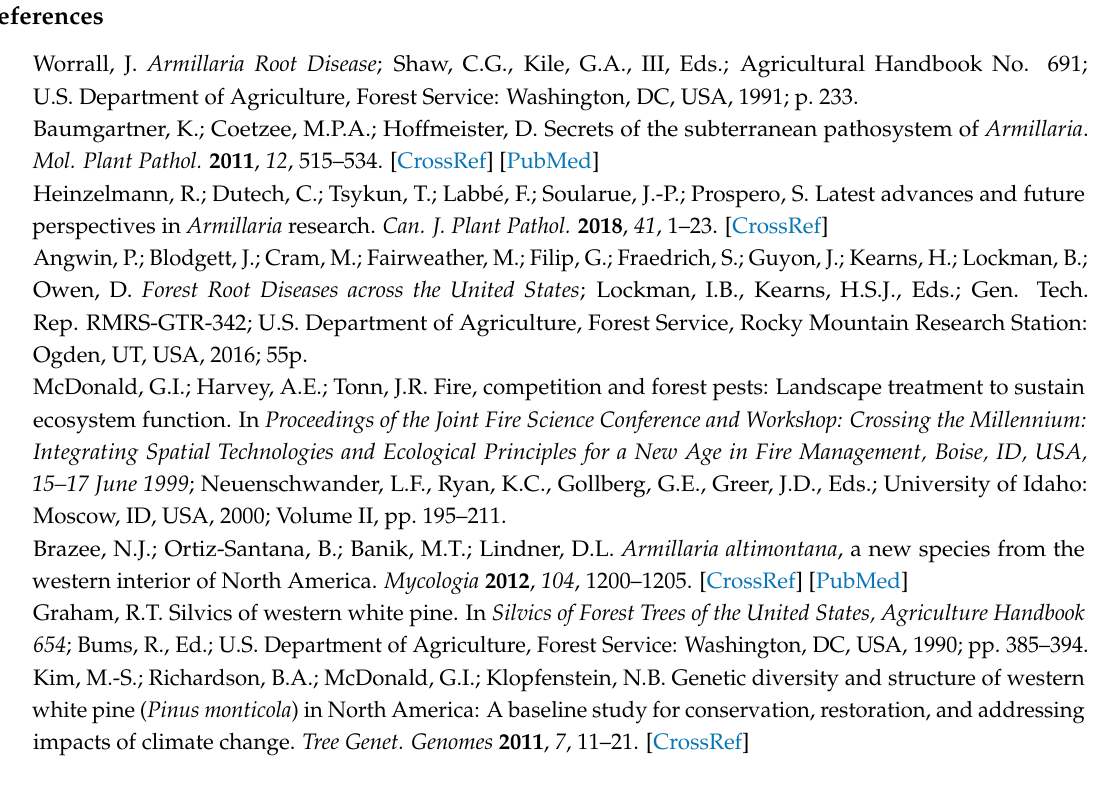
Table S1. The somatic pairing tests to identify the Armillaria genets among the isolates collected from western white pine ( Pinus monticola ) within a plantation at the Ida Creek site, Priest River Experimental Forest, northern Idaho, USA. Table S2. The number of western white pine ( Pinus monticola ) trees by region of seed origin and group status used for the analyses or results presented in Figure 1; Figure 2 and Tables 1–4 for the Ida Creek site, Priest River Experimental Forest, northern Idaho, USA. Table S3. The tree height, DBH, survival, Armillaria colonization status, and disease signs and symptoms data for western white pine ( Pinus monticola ) trees at the Ida Creek plantation, Priest River Experimental Forest, Idaho, USA. Table S4. The Sequence Identity Matrix for Armillaria genets from Ida Creek plantation at the Priest River Experimental Forest, Idaho, USA vs. themselves and the North American Armillaria standards. Figure S1. A graphical summary of (A) the height (Equation (1)) and (C) diameter at breast height (DBH) model fits for residuals vs. observed and the Q-Q plots for (B) height (Equation (1)) and (D) the DBH models of western white pine ( Pinus monticola ) trees growing in Ida Creek plantation within the Priest River Experimental Forest in northern Idaho,